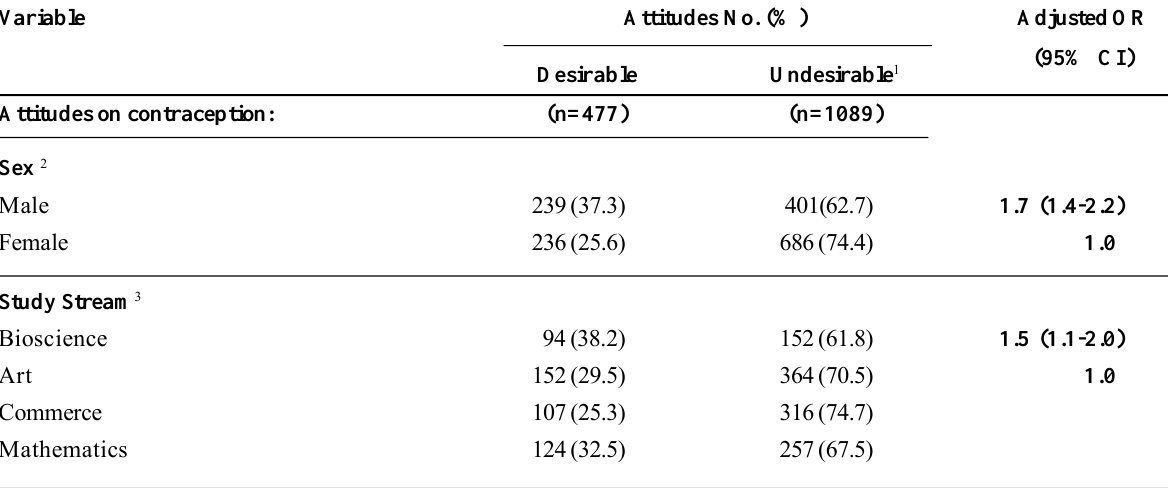
Table 4. Factors associated with overall attitudes on contraception and male